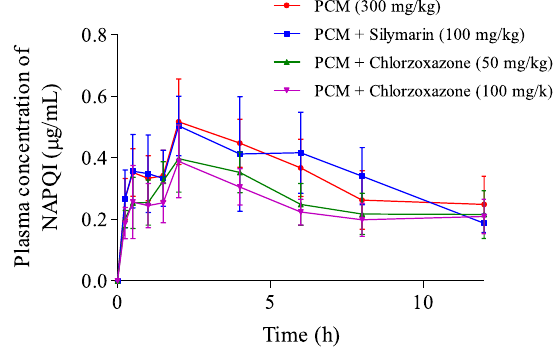
Fig. 4 Time profiles of Mean plasma concentration–time of NAPQI following an oral administration of paracetamol to rats with or without Silymarin and Chlorzoxazone (n 6). (Circles) Control = (paracetamol); (squares) paracetamol with silymarin (100 mg/kg); (traingles) paracetamol with chlorzoxazone (50 mg/kg); (inverted traingles) paracetamol with chlorzoxazone (100 mg/kg). All values are Mean SD. Bars represent the standard deviation. * p < 0.01 compared ± to the paracetamol control group (Two-way ANOVA followed by Bonferroni post-tests to compare each column to column). PCM, Paracetamol; NAPQI,